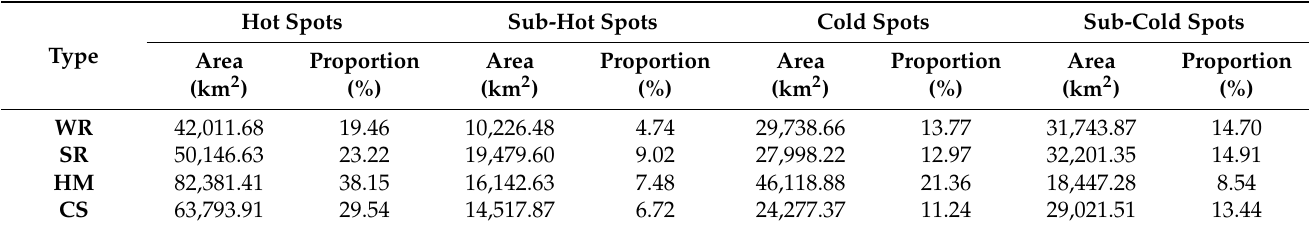
Table 2. Statistics of hot spots and cold spots of ecosystem services.